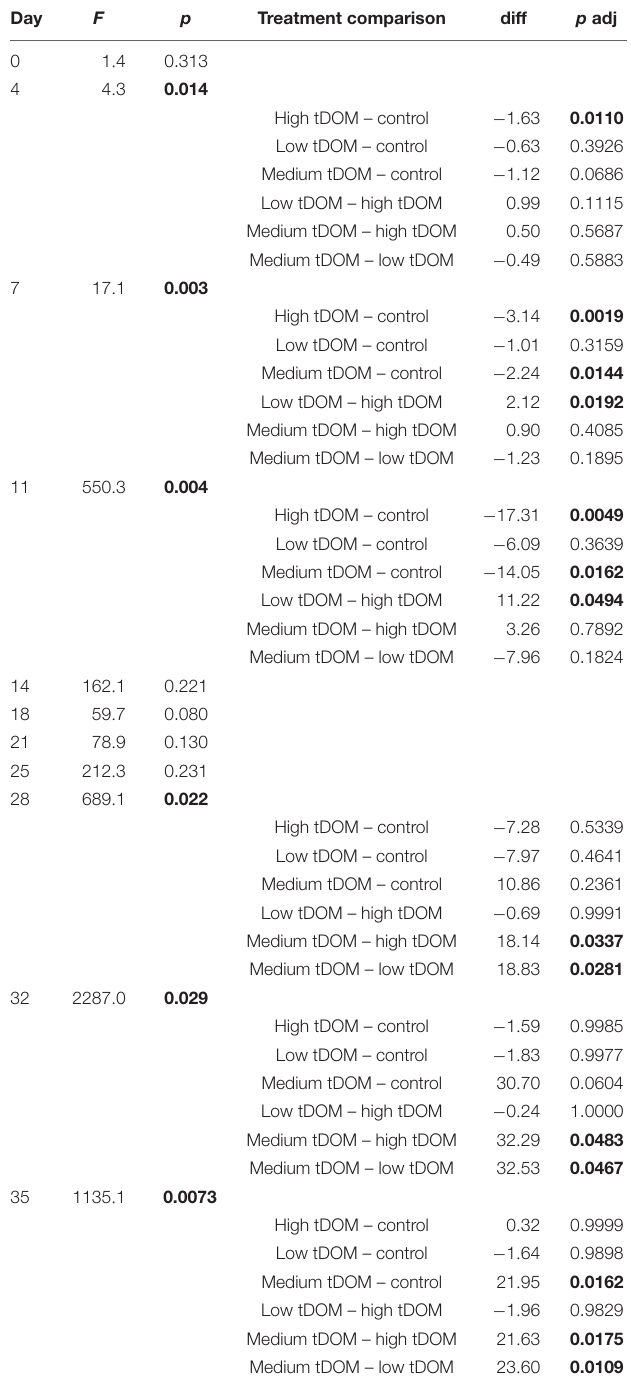
TABLE 2 | ANOVA analyses conducted per day for Chl a concentrations testing for treatment